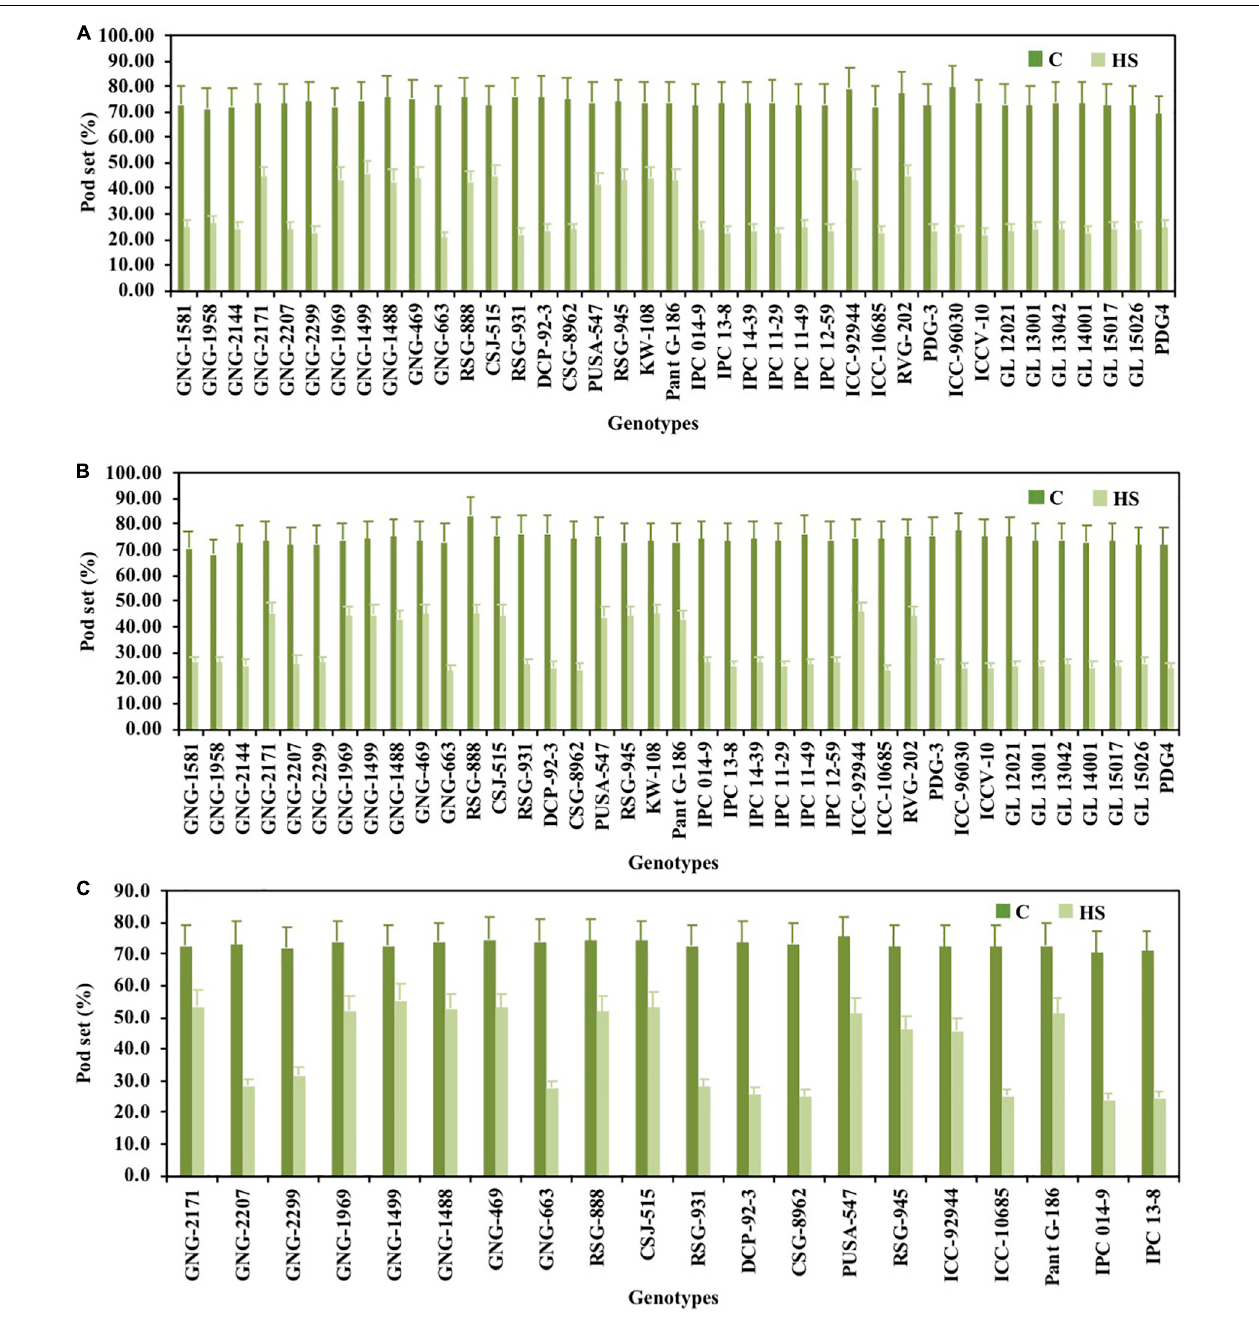
FIGURE 1 | Pod set (%) of chickpea genotypes under control (normal-sown; C) and heat stress (late-sown; HS) environment during 2017–2018 (A) , 2018–2019 (B) and in control environment of growth chamber (GC; C-control; HS-heat stress; C) . LSD values ( P < 0.05); genotype × treatment: 9.3 (2017–2018), 11.3 (2018–2019), 11.7 (GC). Values are means + SE. ( n = 3).